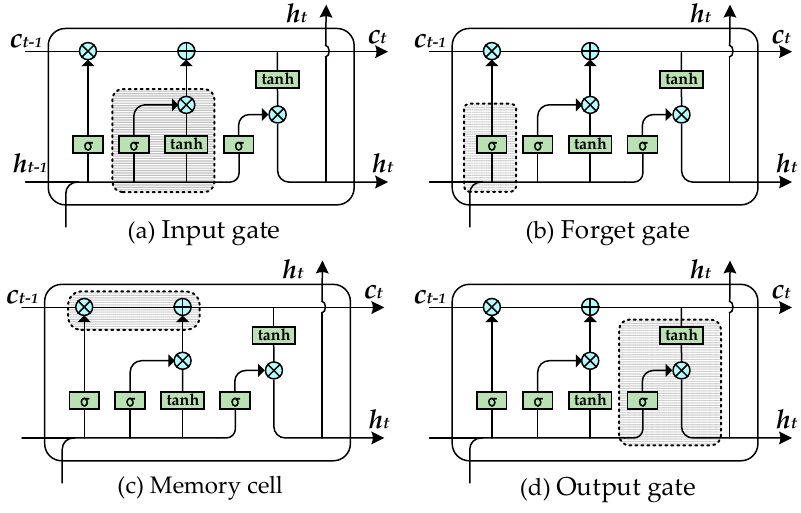
Figure 5. Structure of a long short-term memory (LSTM) block.